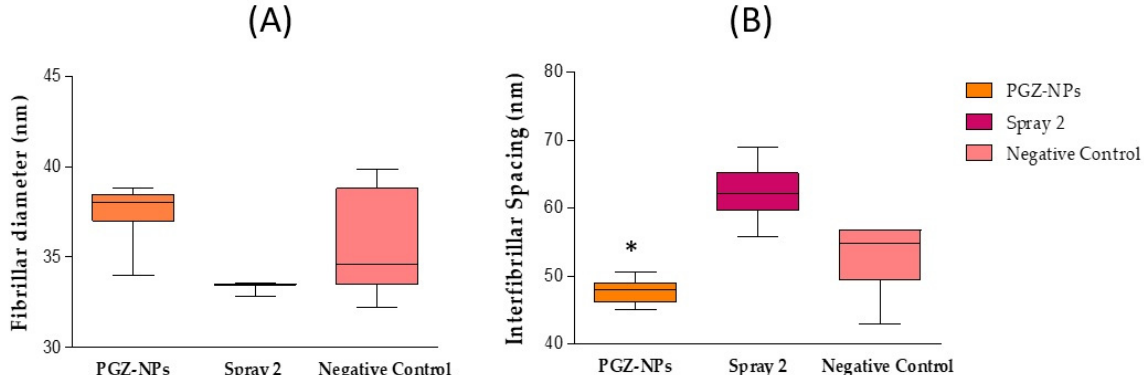
Figure 8. SAXS corneal synchrotron analysis. Collagen fibrillar diameter ( A ) and collagen interfibrillar spacing ( B ) ( n = 2). (* p <